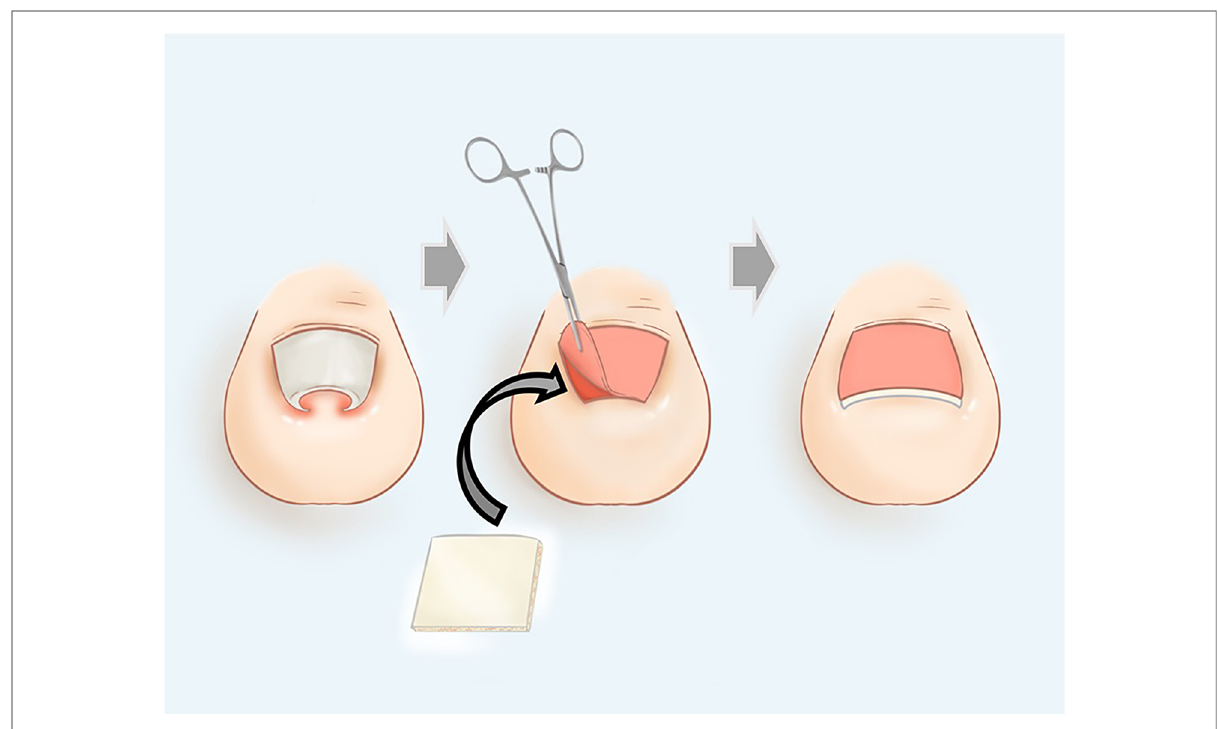
FIGURE 4 Schematic diagram of the